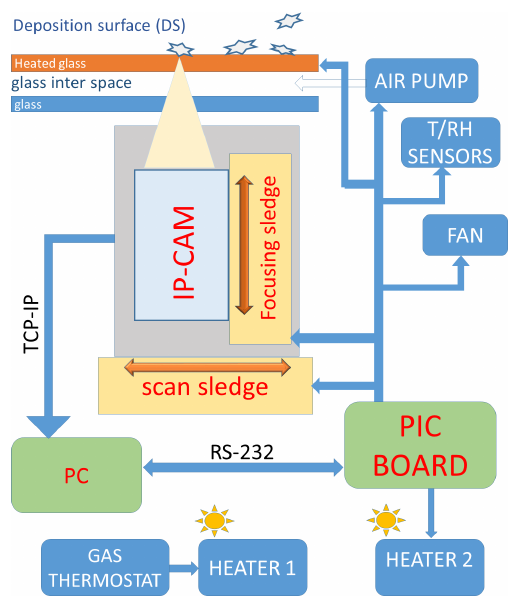
Figure 3. Basic schematics of the